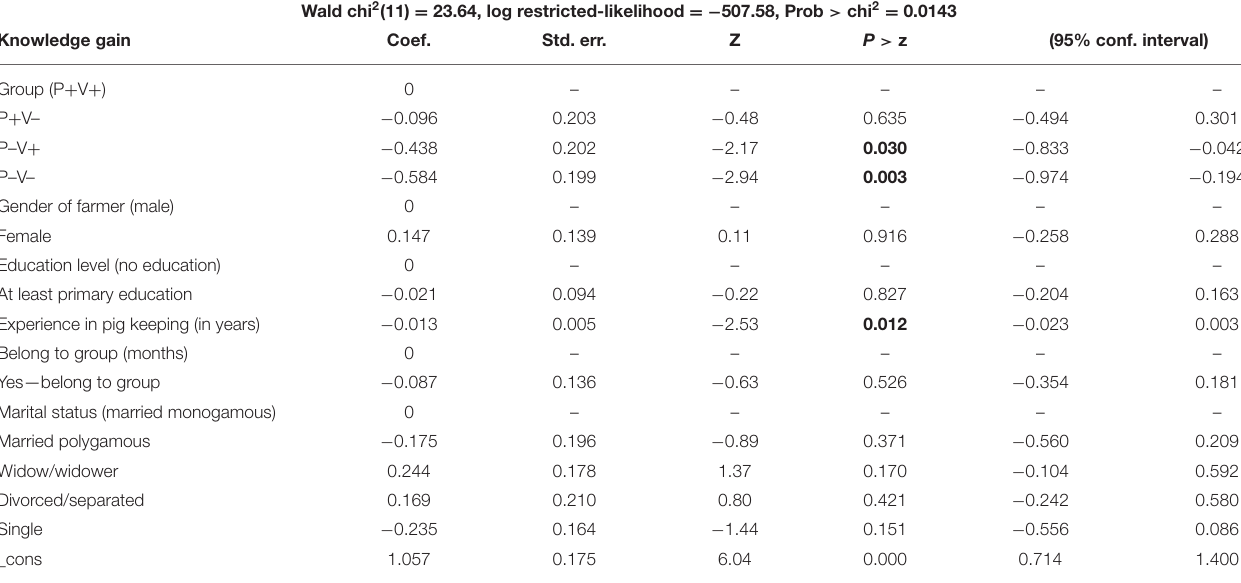
TABLE 4 | Parameter estimates and significant of variables influencing knowledge